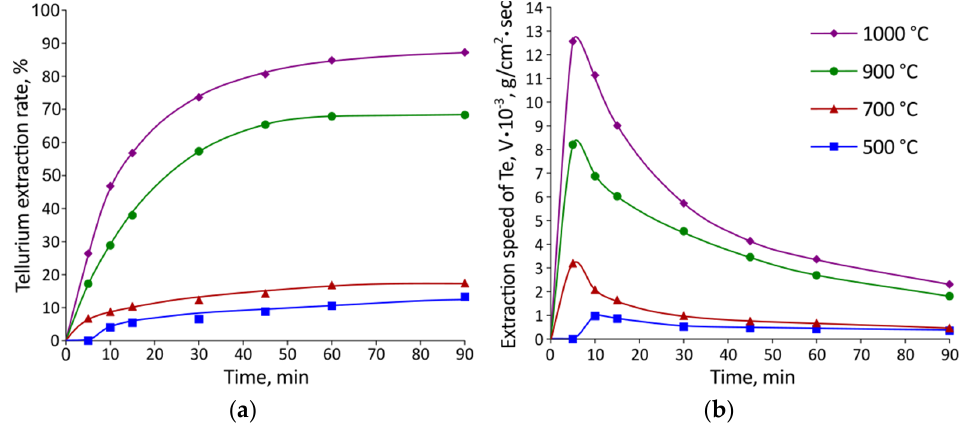
Figure 8. Dependence of the rate ( a ) and speed ( b ) of tellurium extraction on the duration of exposure at different temperatures.